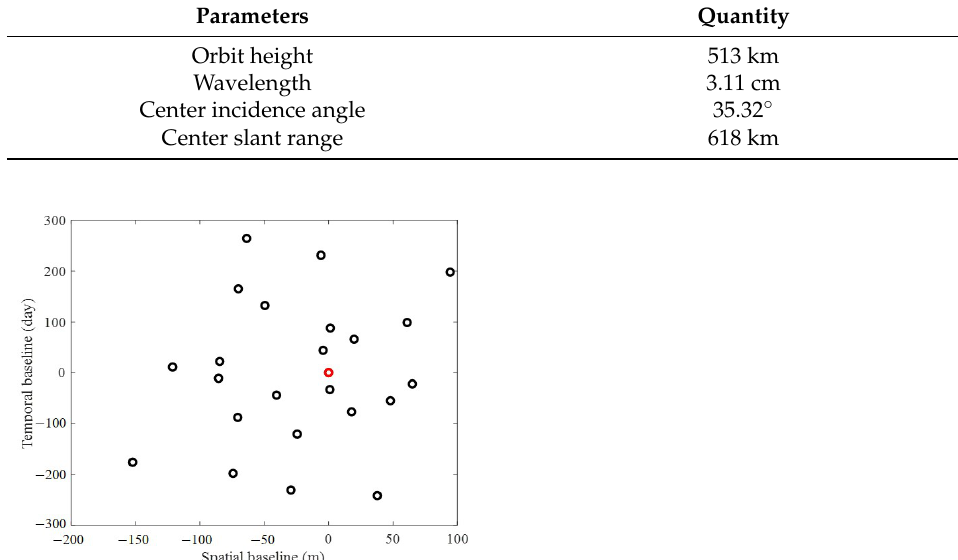
Figure 8. The spatial and temporal baseline configurations of the TerraSAR-X data